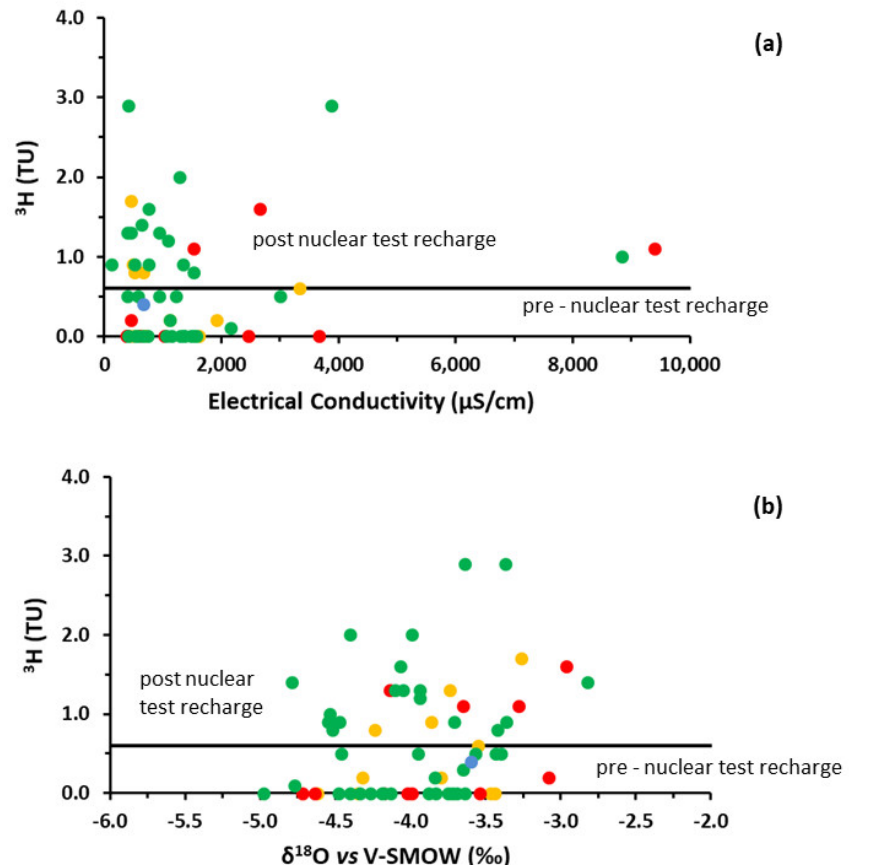
Figure 4. ( a ) Na + vs. Cl − content; ( b ) Na + vs. Cl − content without FT-109; ( c ) Ca 2+ vs. HCO 3 − ( d ) Ca 2+ Figure 11. ( a ) Plot of tritium versus electrical conductivity; ( b ) Tritium content versus δ 18 O. The Figure 11. ( a ) Plot of tritium versus electrical conductivity; ( b ) Tritium content versus δ 18 O. The Figure 3. Piper diagram for Santiago Island groundwater samples. The symbols stand for: (  ) base vs. HCO 3 − without FT-109. The symbols stand for: (  ) base unit formation; (  ) middle unit for- Figure 11. ( a ) Plot of tritium versus electrical conductivity; ( b ) Tritium content versus δ 18 O. The unit formation; (  ) middle unit formation; (  ) recent unit formation. mation; (  ) recent unit formation. ) Recent Unit formation symbols stand for: ( Figure 3. Piper diagram for Santiago Island groundwater samples. The symbols stand for: (  ) base ) Base Unit formation; ( symbols stand for: (  ) Base Unit formation; (  ) Middle Unit formation; (  ) Recent Unit formation symbols stand for: (  ) Base Unit formation; (  ) Middle Unit formation; (  ) Recent Unit formation unit formation; (  ) middle unit formation; (  ) recent unit formation. and (  ) not labeled unit formation. ) not labeled unit and (  ) not labeled unit formation.